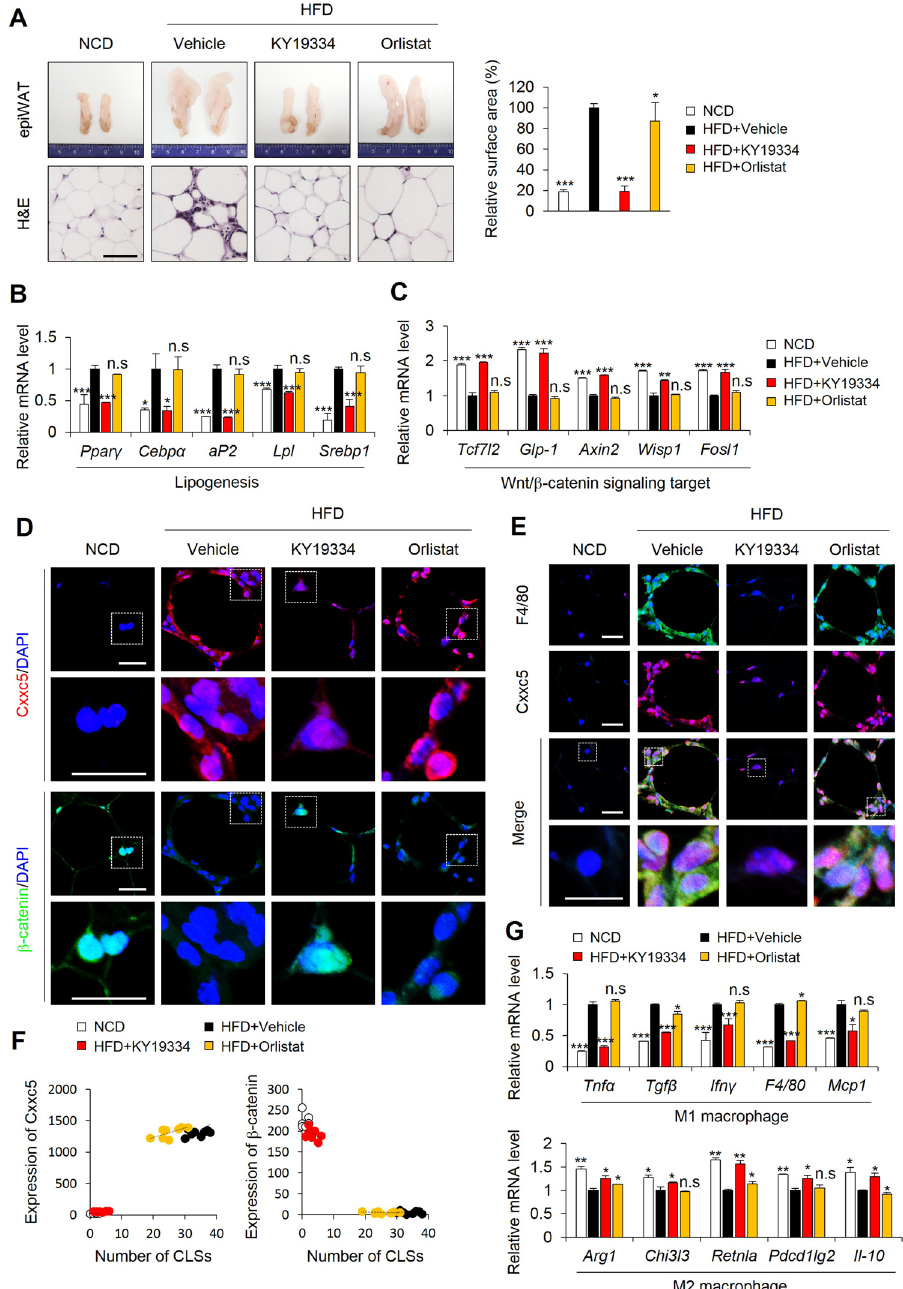
Figure 3. KY19334 treatment reduces adipogenesis and inflammation in epiWAT. C57BL/6 mice fed the NCD or HFD were administered as described in the legend of Fig. 2. ( A ) Representative images of epiWAT and H&E staining. Quantification analyses of adipocyte cell size of epiWAT. ( B , C ) Relative expression levels of marker genes for lipogenesis ( B ) and Wnt/β-catenin signaling target ( C ) ( n = 3 per group). ( D ) Representative IHC images for Cxxc5 and β-catenin in the epiWAT. Quantitative mean intensity value of IHC staining of Cxxc5 and β-catenin. ( E ) Representative IHC images for F4/80 and Cxxc5 in the epiWAT. ( F ) The correlation of Cxxc5 and β-catenin expression with the number of CLSs. ( G ) Relative expression levels of marker genes for M1 and M2 macrophage. Scale bar, 100 µm. Results are expressed as mean ± SD., n = 3 per group, * P < 0.05, ** P < 0.01, *** P < 0.001, n.s indicates non-significance with HFD-fed vehicle group. NCD normal chow diet, HFD high-fat diet, epiWAT epididymal white adipose tissue, CLSs crown-like